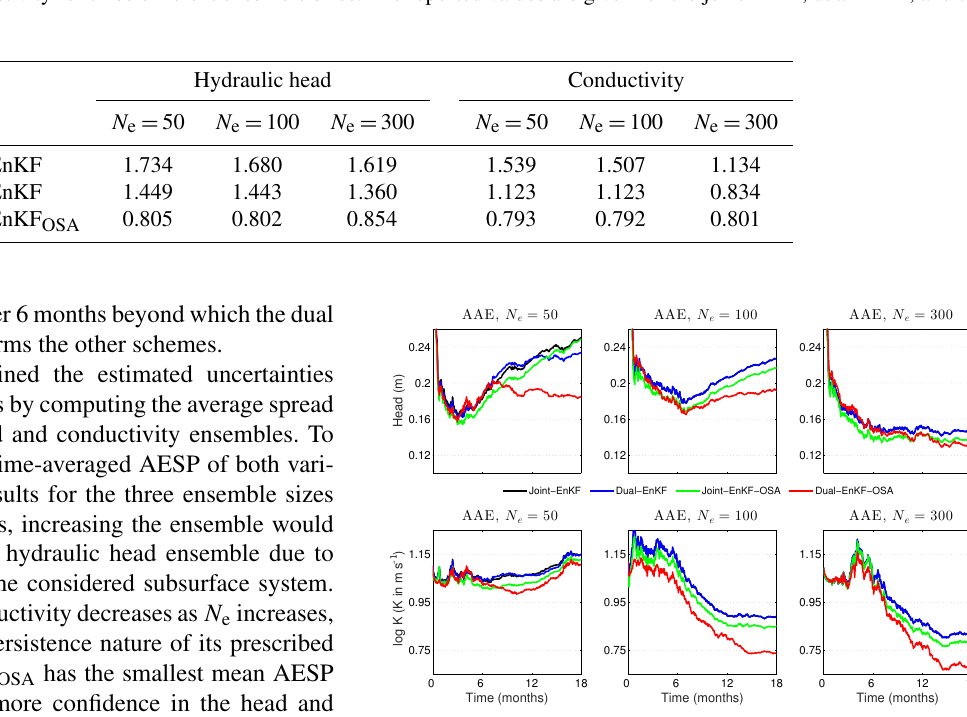
Figure 4. AAE time series of the hydraulic head and conductiv- ity using the joint EnKF, dual EnKF, joint EnKF OSA , and dual EnKF OSA . Results are shown for three scenarios in which assim- ilation of hydraulic head data are obtained from nine wells every 0.5 days. The three experimental scenarios use 50, 100, and 300 en- semble members with 0.50m as the measurement error standard